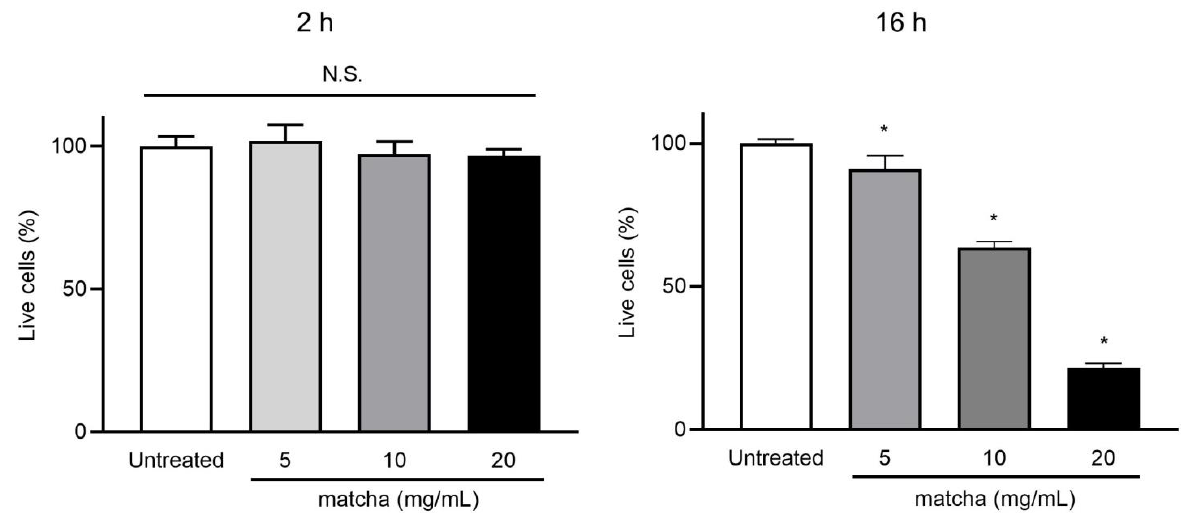
Figure A2. Cytotoxicity of matcha supernatant toward A549. The human alveolar epithelial cell line A549 was treated with various concentrations of matcha supernatants (5, 10, and 20 mg/mL) for 2 h or 16 h. MTT assays were performed to determine cell viability. Data represent the mean ± SD ( n = 3 per group) of quintuplicate determinants, and were evaluated using Dunnett’s multiple comparisons test. * p < 0.05 versus the untreated group. N.S.; Not Significant.